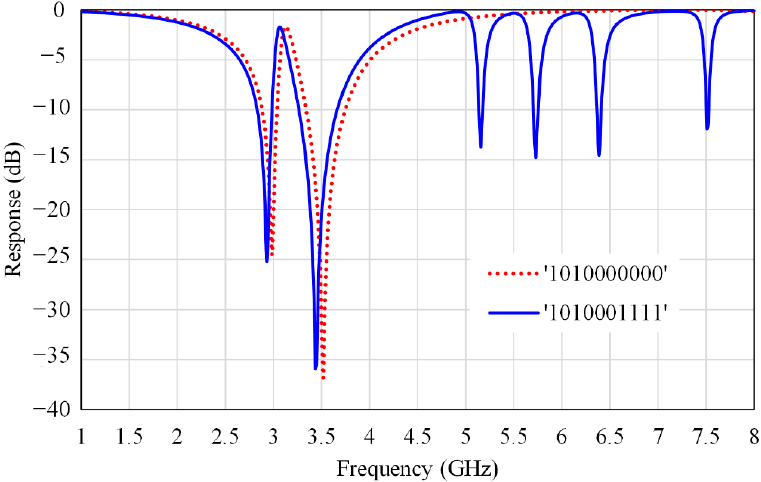
Figure 6. Simulated response of the M − strips tag with two different codes: 1010101010 and 0101010101.